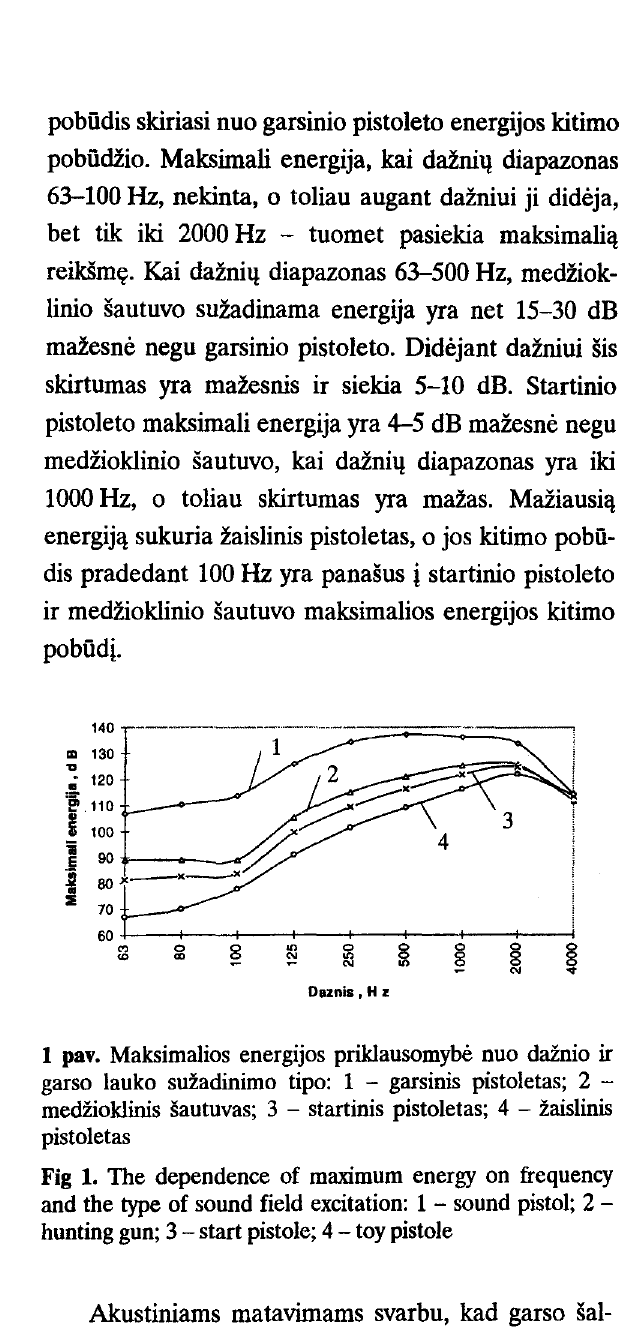
Fig 1. The dependence of maximum energy on frequency and the type of sound field excitation: 1 - sound pistol; 2 - hunting gun; 3 - start pistole; 4 - toy pistole